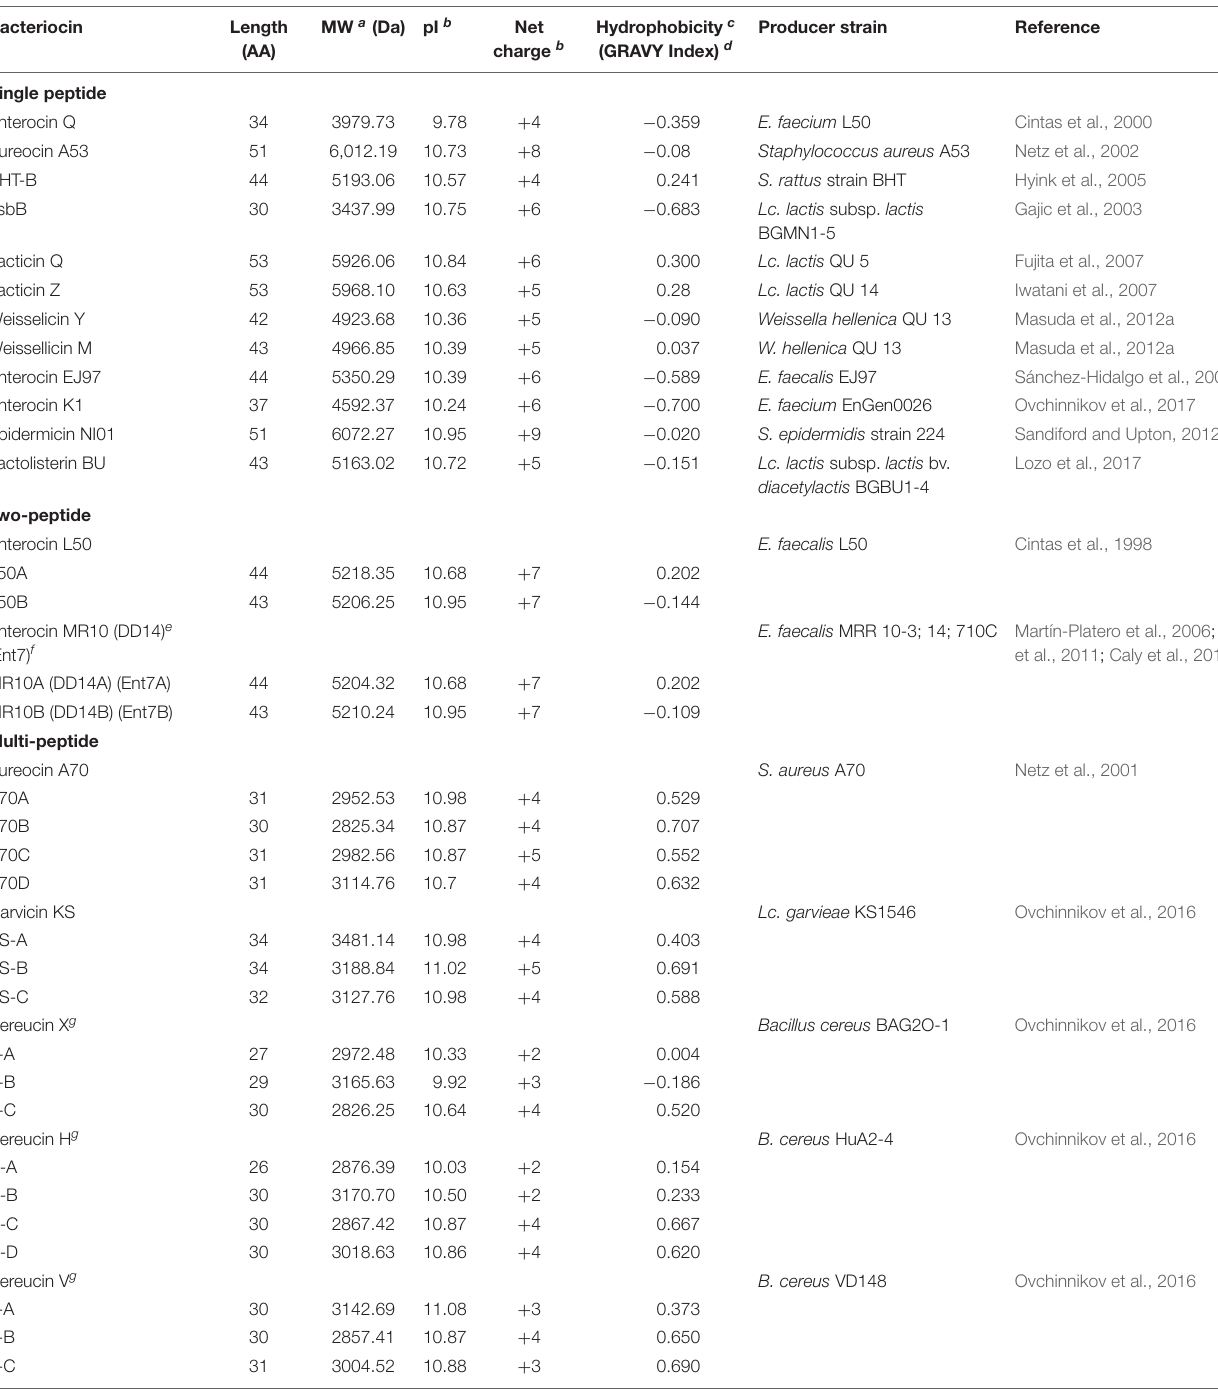
TABLE 2 | Relevant characteristics of different leaderless